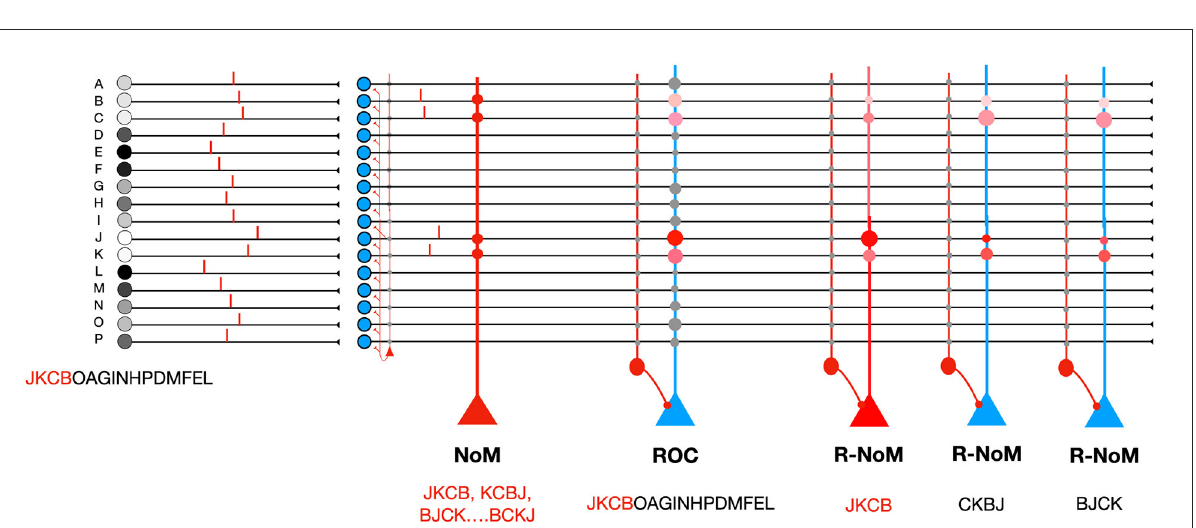
FIGURE2 Comparison of different codes. On the left, the M 16 afferents fire in the order JKCBOAGINHPDMFEL, but a 4-winner-take-all mechanism = only lets the N 4 first spikes through. NoM coding: the readout neuron uses binary weights: W = potential reaches the maximal value of 4 if the N first spikes correspond to the W non-zero weights. The order of these 4 first spikes does not matter. Rank Order coding ROC. : the neuron is set up to respond maximally to the order JKCBOAGINHPDMFEL, even though here only the 4 input spikes are propagated. Ranked-NoM coding R-NoM :: we show three readout neurons that are selective to three different orders for the 4 first spikes, among the 4! 24 possible orders, thanks to graded weights and modulations, both in =